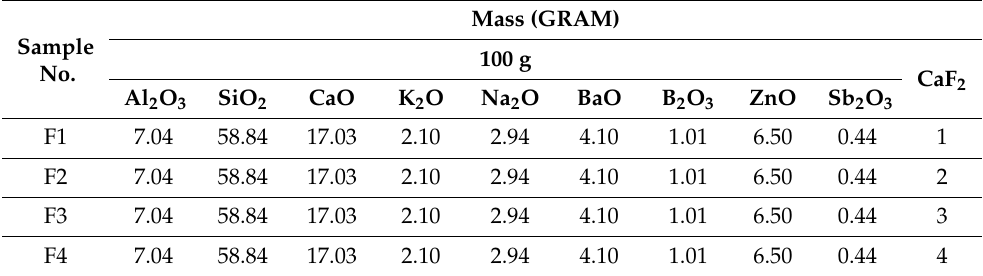
Table 1. Chemical compositions of the designed parent glasses.